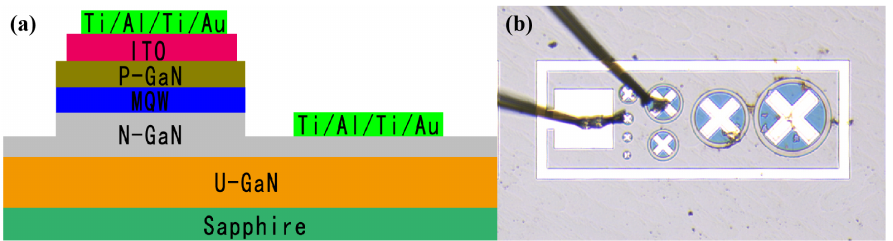
Figure 3. Image of the 80 µ m × 80 µ m InGaN-based Micro-LED: ( a ) schematic diagram, ( b ) micro- scope image.